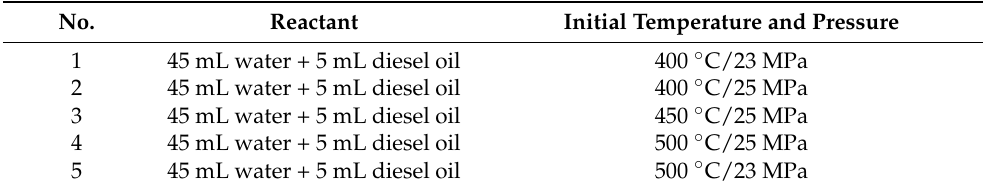
Table 1. Experimental parameters of supercritical water–diesel reactions to generate supercritical multi-thermal fluid under different temperature and pressure conditions.